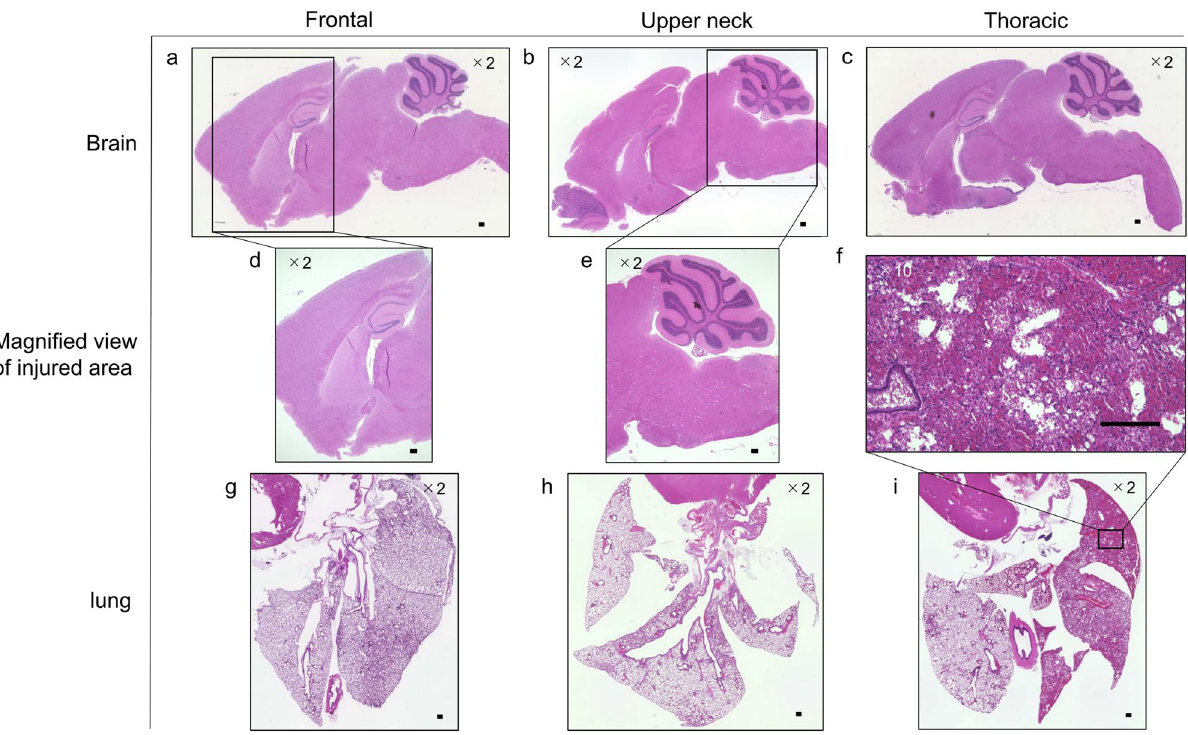
Figure 3. HE-stained brain and lung after application of the LISW. ( a , d ) HE-stained brain specimen after application of the LISW in the Frontal group. ( b , e ) HE-stained brain specimen after application of the LISW in the Upper neck group. (c) HE-stained brain specimen after application of the LISW in the Thoracic group. ( a – e ) No obvious pathological changes were observed. ( f , i ) HE-stained lung specimen after application of the LISW in the Thoracic group. There were alveolar hemorrhage associated with alveolar wall elongation and capillary destruction. ( g ) HE-stained lung specimen after application of the LISW in the Frontal group. ( g ) HE-stained lung specimen after application of the LISW in the Upper neck group. ( g , h ) No obvious pathological changes were observed. ( a – i ) scale 200